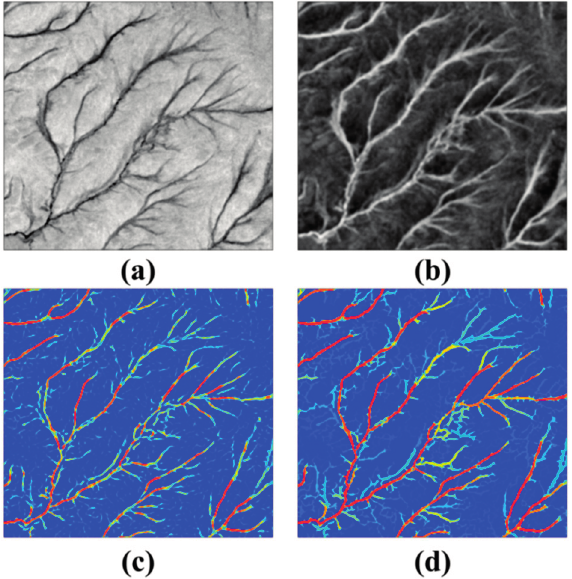
Figure 1. ( a ) Landsat 8 OLI panchromatic image of example river networks distributed in the Yukon River Basin, northwestern North America, and ( b ) its corresponding three-dimensional (3D) view, in which pixel values in the original image are inversed for comparison convenience. The (0, 0) point in the 3D view corresponds to the top-left pixel of the image.